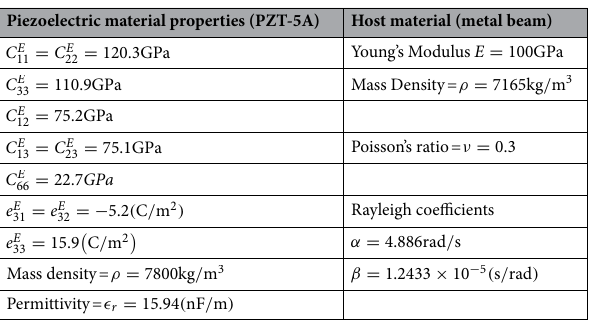
Table 3. Material properties of host beam and piezoelectric patch for validating the energy harvester model.